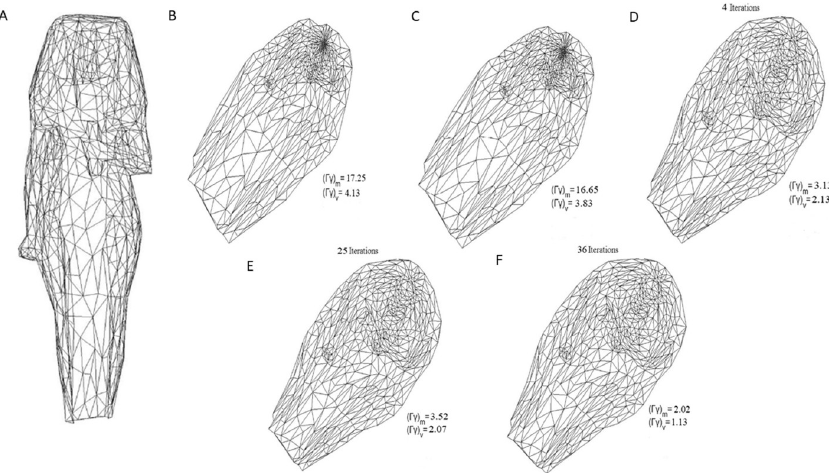
Fig 17. Parameterization experiments on ISIS model. (A) original mesh model, (B) result by LABF, (C) result by LQHP, (D) result by IQCP;,(E) result by QCTM, (F) result by our